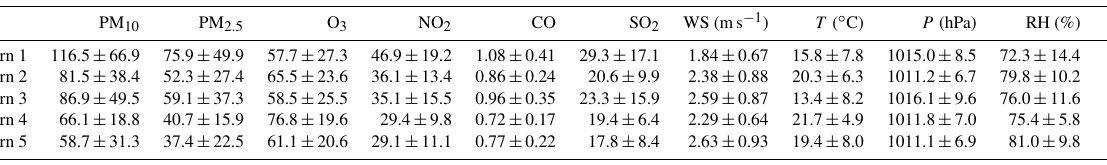
Table 5. The average values of air pollutant concentrations (µgm − 3 for PM 10 , PM 2 . 5 , O 3 , NO 2 and SO 2 ; mgm − 3 for CO) and meteorolog- ical factors for the 16 typical YRD cities under different synoptic weather patterns.